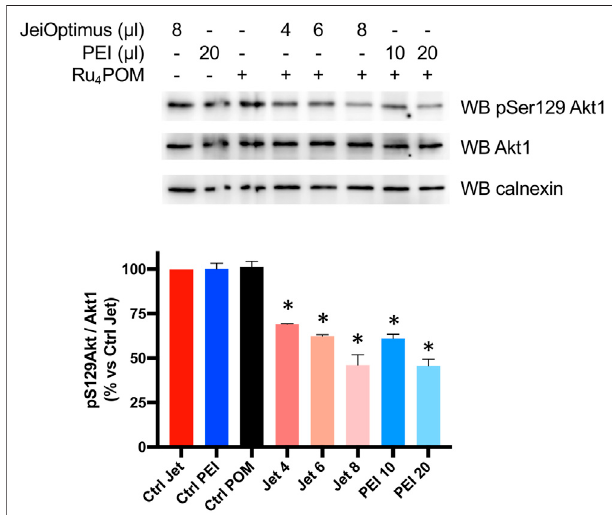
FIGURE4| CellularactivityofRu 4 POM.HEK-293Tcellsweretreatedfor 24 h as indicated. Ru 4 POM was used at 10 μ M. 20 μ g protein from total cell lysates were analyzed by SDS-PAGE and Western blot (WB) with the indicated antibodies. Calnexin wasused as loading control. Quantitation of the signal is shown on the bottom panel (mean values ± SEM of two independent experiments). * p < 0.05.